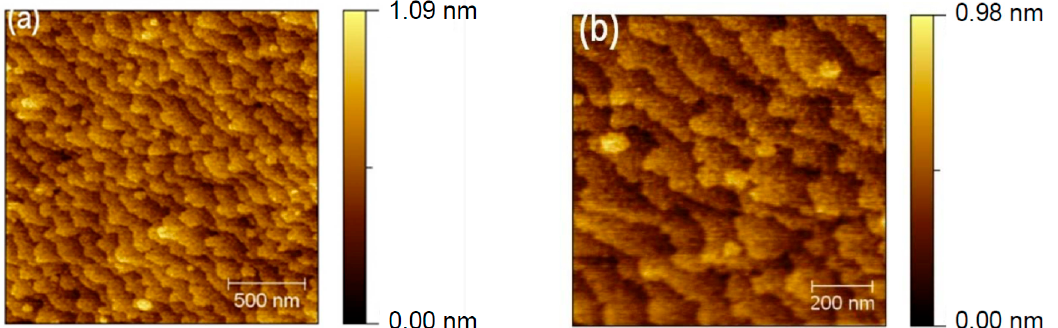
Figure 5. ( a ) AFM picture of surface structure of InAlAs 2.5 µm thick layer grown on InP (001) substrate at the optimal conditions T g = 480 °C, V/III ratio = 26; ( b ) an enlarged picture of the surface.